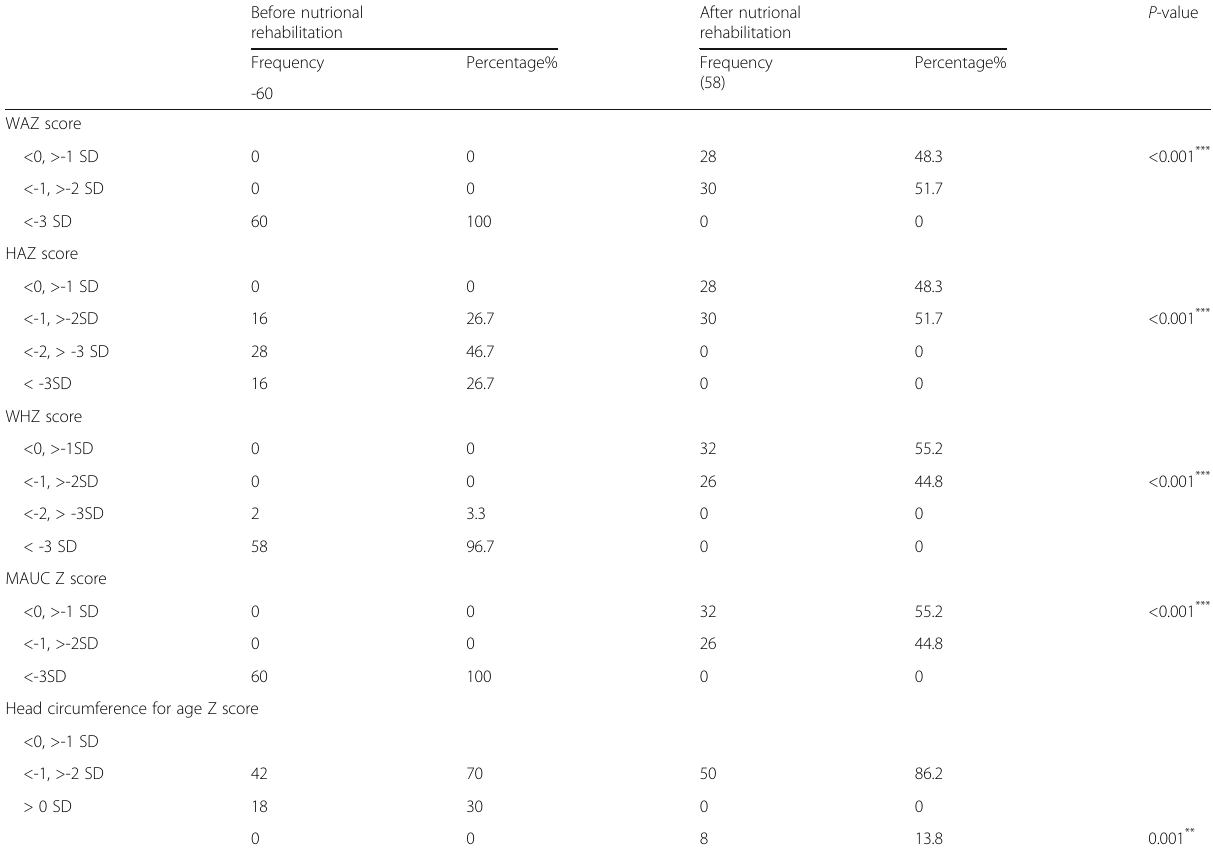
Table 2 Comparison between at admission and after nutritional rehabilitation anthropometric measurements in children with severe acute malnourished (SAM)